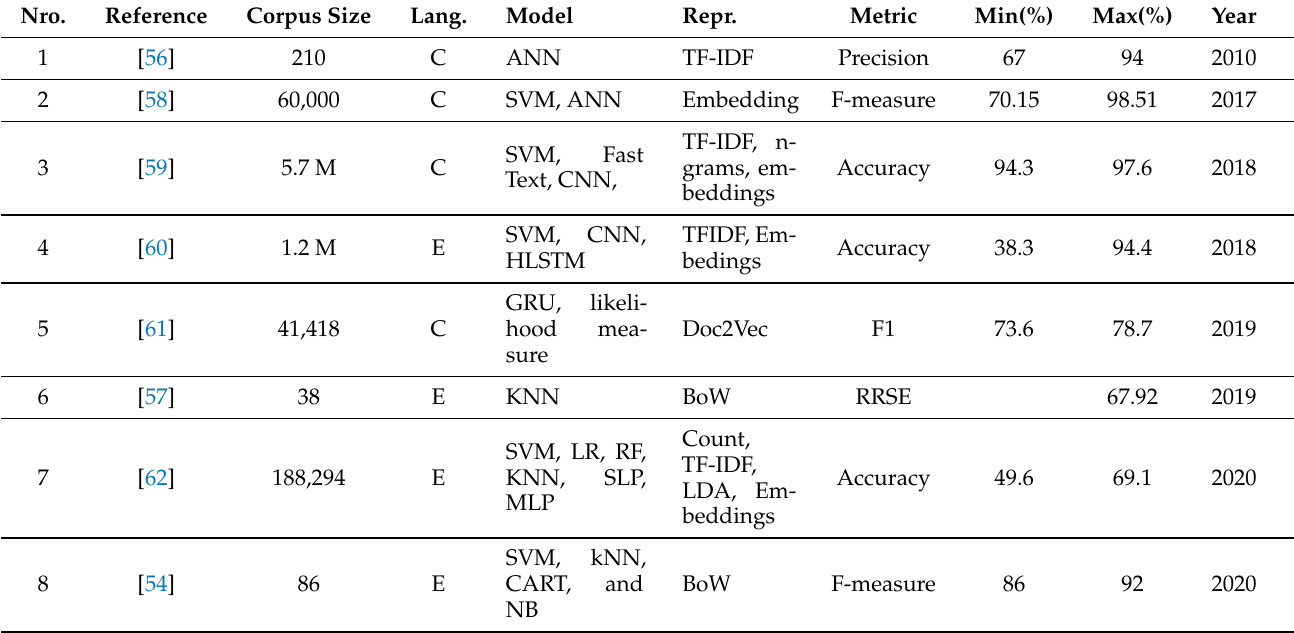
Table 5. Summary of ruling decision prediction in Criminal Law, where C = Chinese, E = English, F = French, P = Portuguese and S =